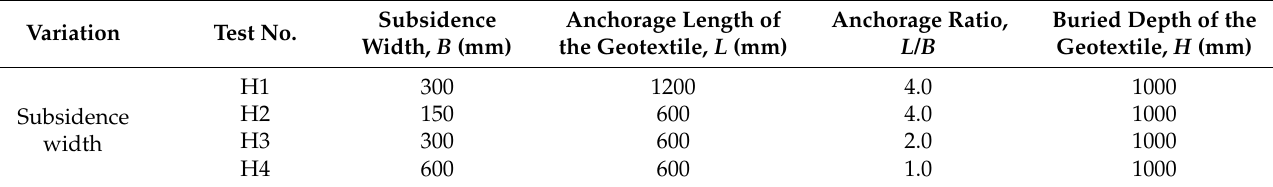
Table 1. Model test program.